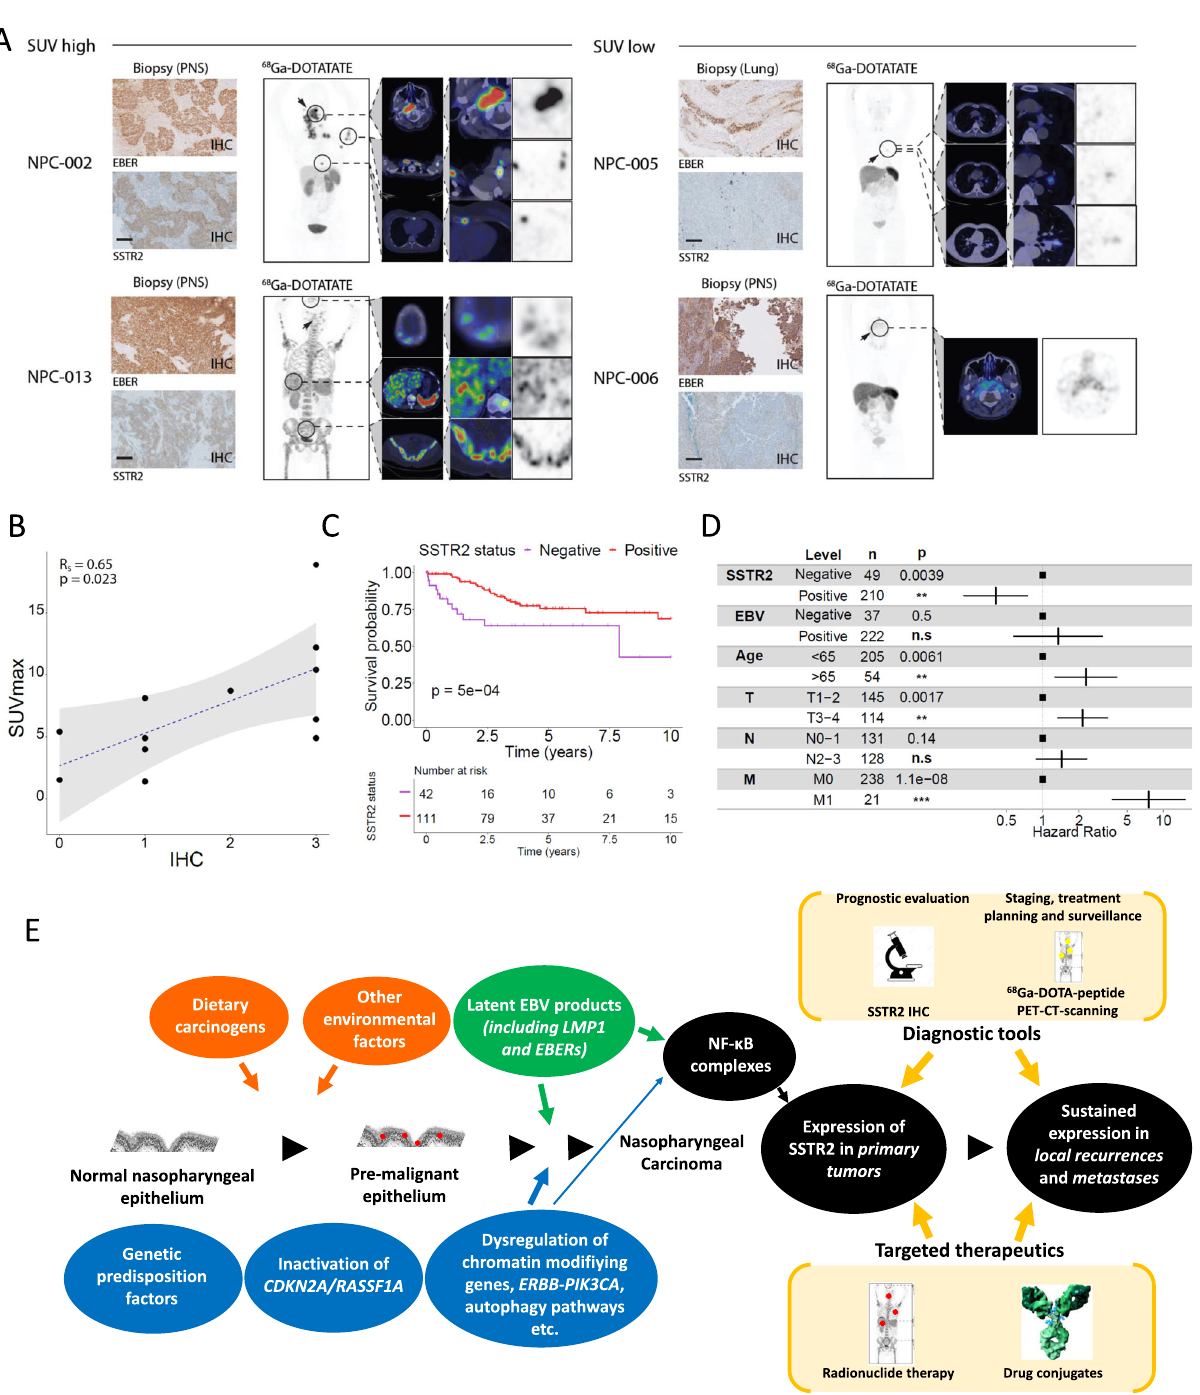
Fig. 3 In vitro and in vivo effects of SSTR2 agonists on the C666-1 NPC cell line. a Immunohistochemical characterization of C666-1, NPC43, and C17 cell lines cultured in vitro and from xenografted C666-1, C15, C17, or C18 tumor tissues (scale bar 100 µ m); Replication n = 2. b In vitro dose response curves and half-maximal effective concentration (EC50 values) of the indicated SSTR agonists on C666-1, NPC43, and C17 cells. EC50 = half-maximal effective concentration. c Growth curves of C666-1 tumors in nude mice treated with vehicle ( n = 9), octreotide ( n = 9), or PEN-221 ( n = 8). The dotted lines indicate the time points of drug injection. d Kaplan – Meier curves of athymic nude mice with C666-1 tumors, treated with vehicle control ( n = 9), octreotide ( n = 9), or PEN-221 ( n = 8), with dotted lines showing time points of drug or vehicle injection (* p = 0.0368; two-sided Log-rank Mantel-Cox test). e Geneset enrichment analysis reveals upregulation of senescence pathways 24 h post lanreotide treatment (left), and upregulation of apoptosis and mitotic spindle assembly pathways 24 h post-PEN-221 treatment (right) in treated vs untreated cell lines. f mRNA sequencing analysis of C666-1 cells treated in vitro (72 h with PEN-221) reveals downregulation of SSTR2 expression (two-sided Wald test, adjusted p = 3.9e-7). Center line displays the median, boxes display the interquartile range. Whiskers display 1.5× the interquartile range. Source Data are provided as a Source data